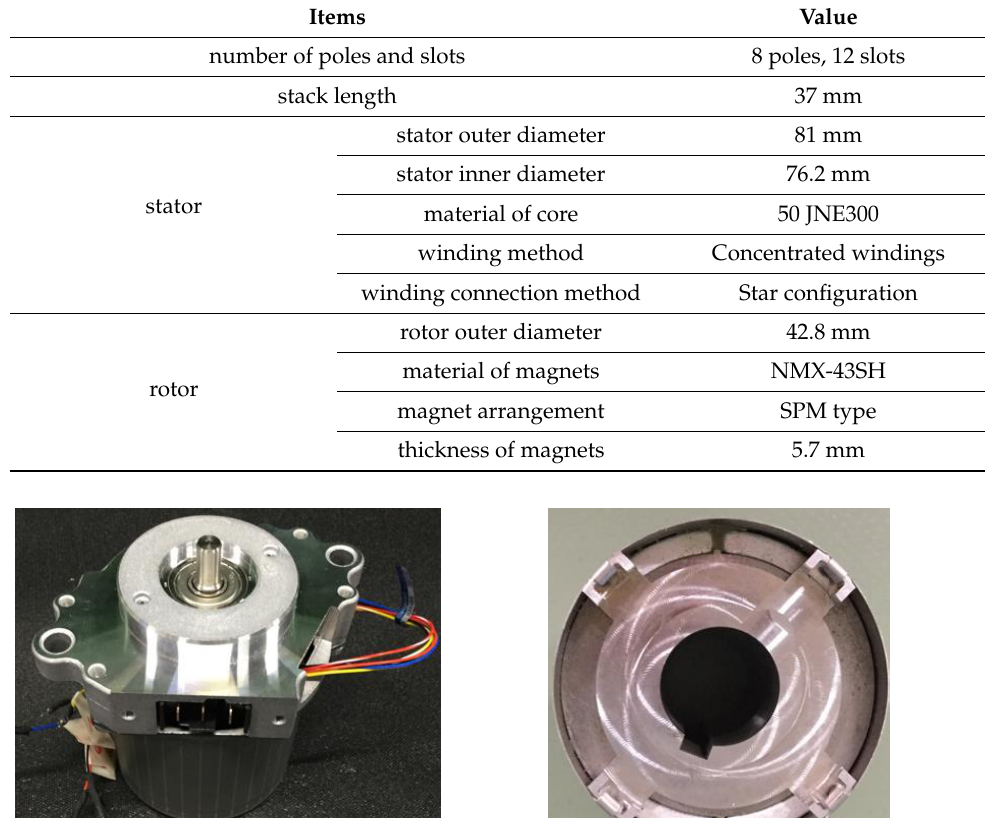
Table 2. Specifications of novel consequent-pole prototype motor.